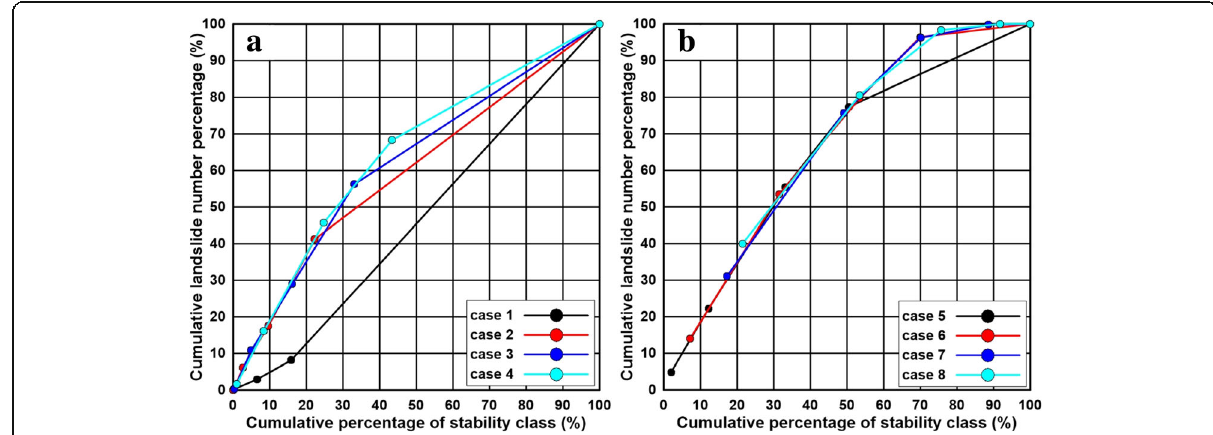
Fig. 11 Cumulative landslide percentages of five stability classes for eight cases